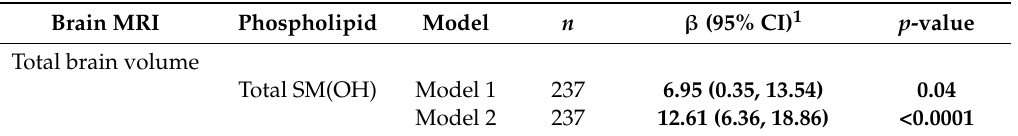
Table 5. Weighted* linear associations of Total SM(OH) (log-transformed per 1-SD difference) with total brain volume, Atherosclerosis Risk in Communities (ARIC) Study, 2011 to 2013. Brain MRI Phospholipid Total brain